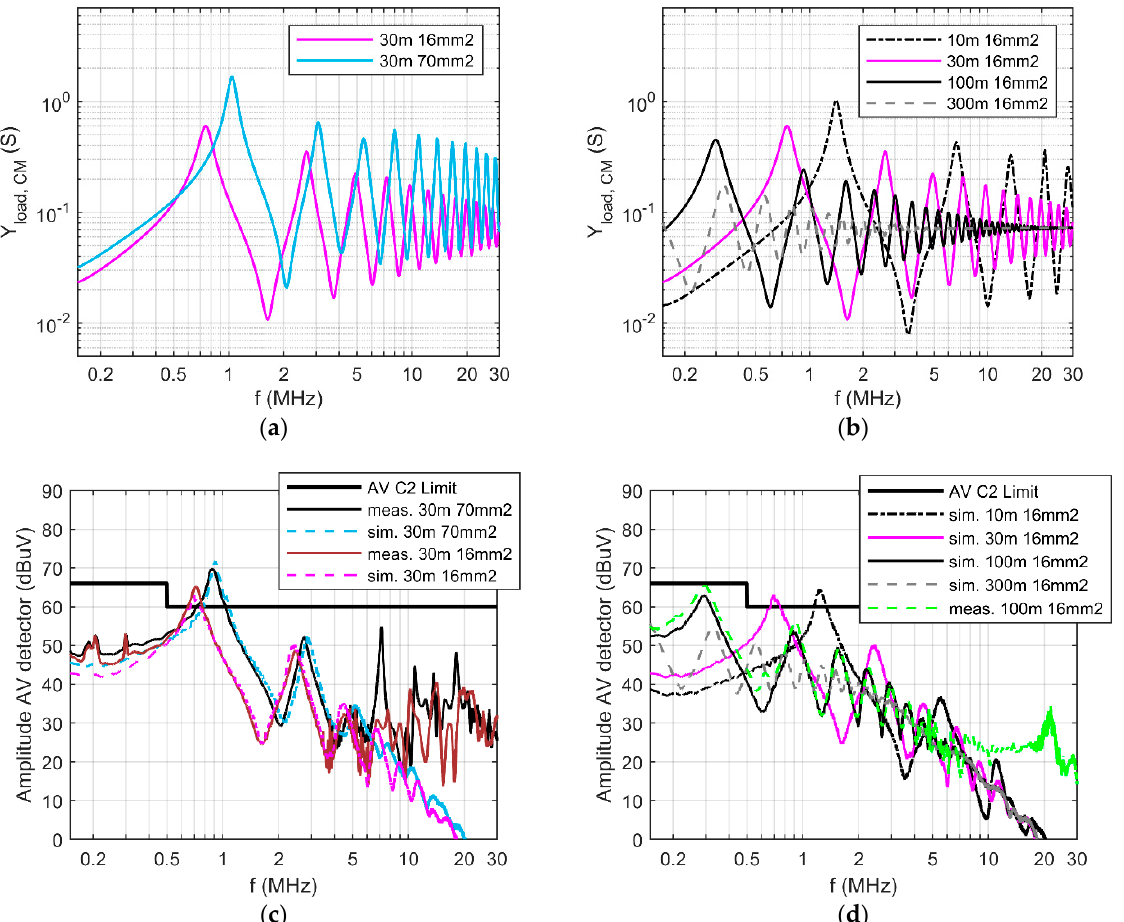
Figure 9. CM admittances Y load of different motor cables terminated with 45 kW motor are shown in subfigures ( a , b ). The CM noise emissions of the full system when using these cables are shown in subfigures ( c , d ). The impact of cable type (for the same cable length of 30 m) on load admittance and noise emissions is shown in ( a , c ) and the impact of cable length (for same cable type with a 16 mm 2 cross section of each conductor) is shown in ( b , d ).